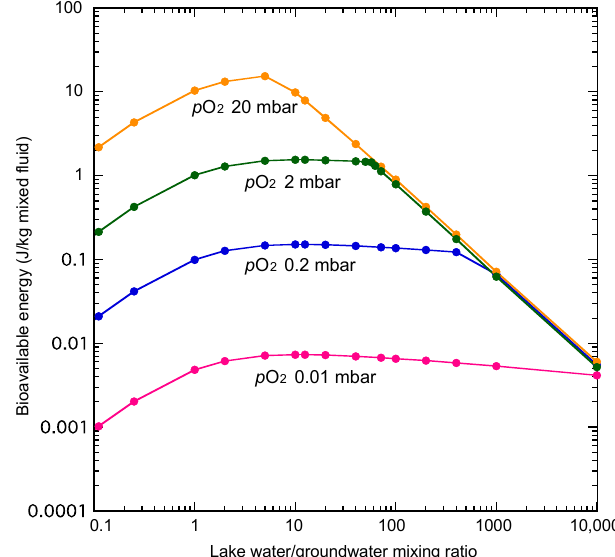
Figure A4. Bioavailable energy (J/kg mixed fluid) from aerobic Fe 2+ -oxidizing magnetite formation